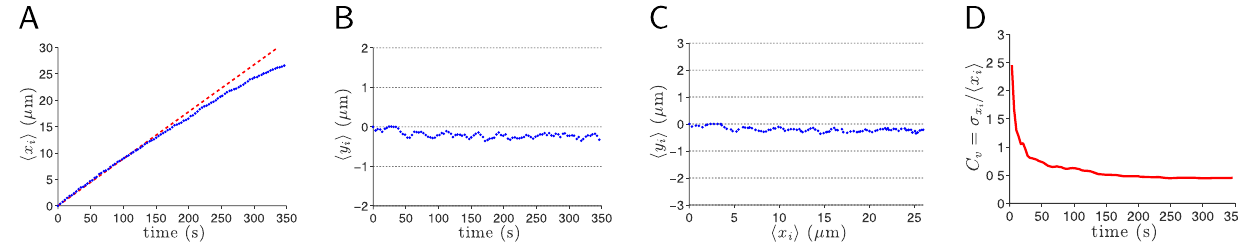
Figure 5. Lagrangian tracking of cells in the ( xy ) -plane of the microchannel. A sample of 205 cells crawling over a plastic hydrophobic surface were subjected to a shear stress s ~ 0.18 Pa in the positive x -direction, with a soluble calcium concentration of 3 mM. Hundred time samples were collected every 3.5 seconds. (A) Odograph S x i T ( t ) for the average cell position along the signal direction (blue dots). The red dashed line corresponds to a purely uniform translation with u x ~ 0 : 089 m m : s { 1 . (B) Odograph S y i T ( t ) for the average cell position transversely to the signal = S x i T vs. time for the motion along the signal direction. direction. (C) Average cell trajectory ( S x i T , S y i T ) . (D) Coefficient of variation C u ~ s x i